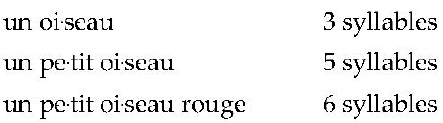
Figure 9. French syllable-timed rhythm.